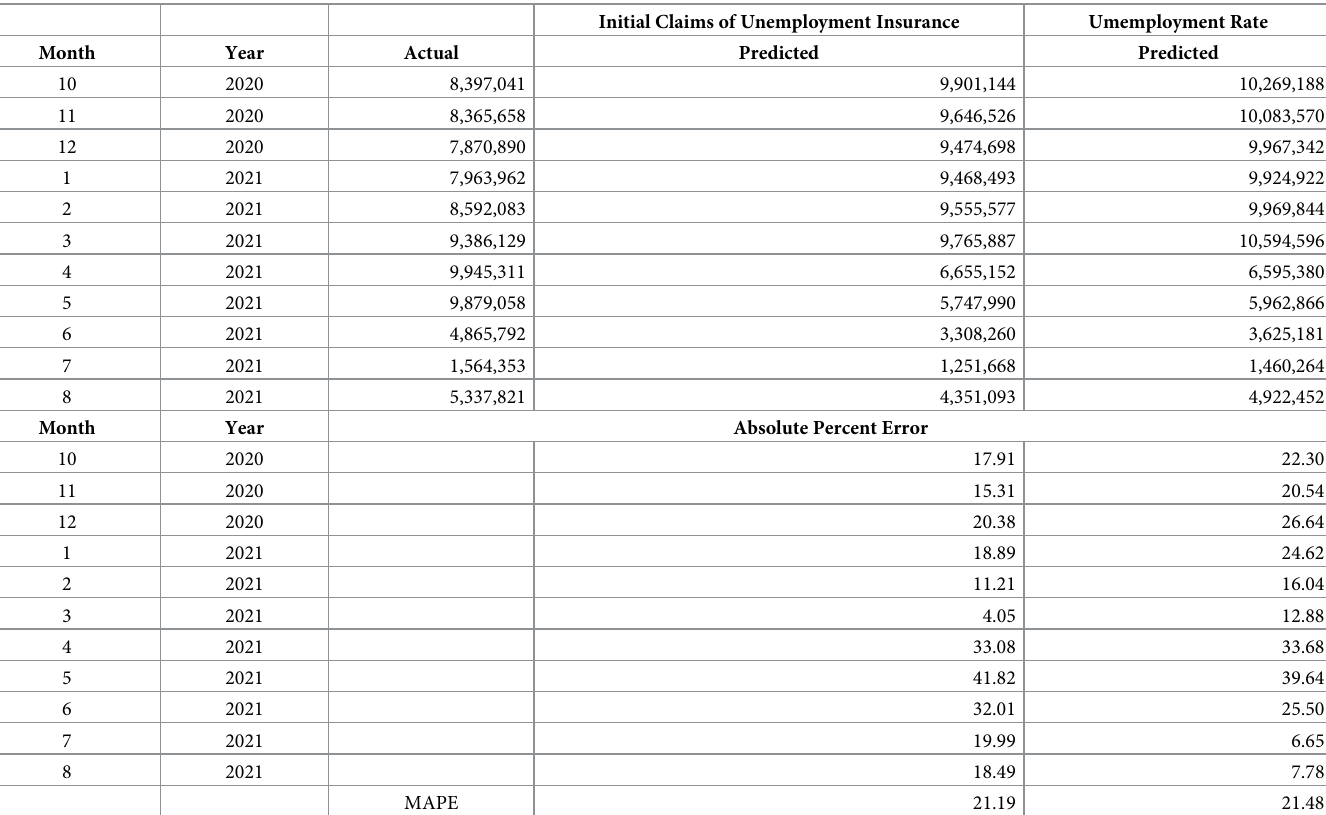
Table 9. Out-of-Sample predictive ability of NSLP distributed lag models by macroeconomic